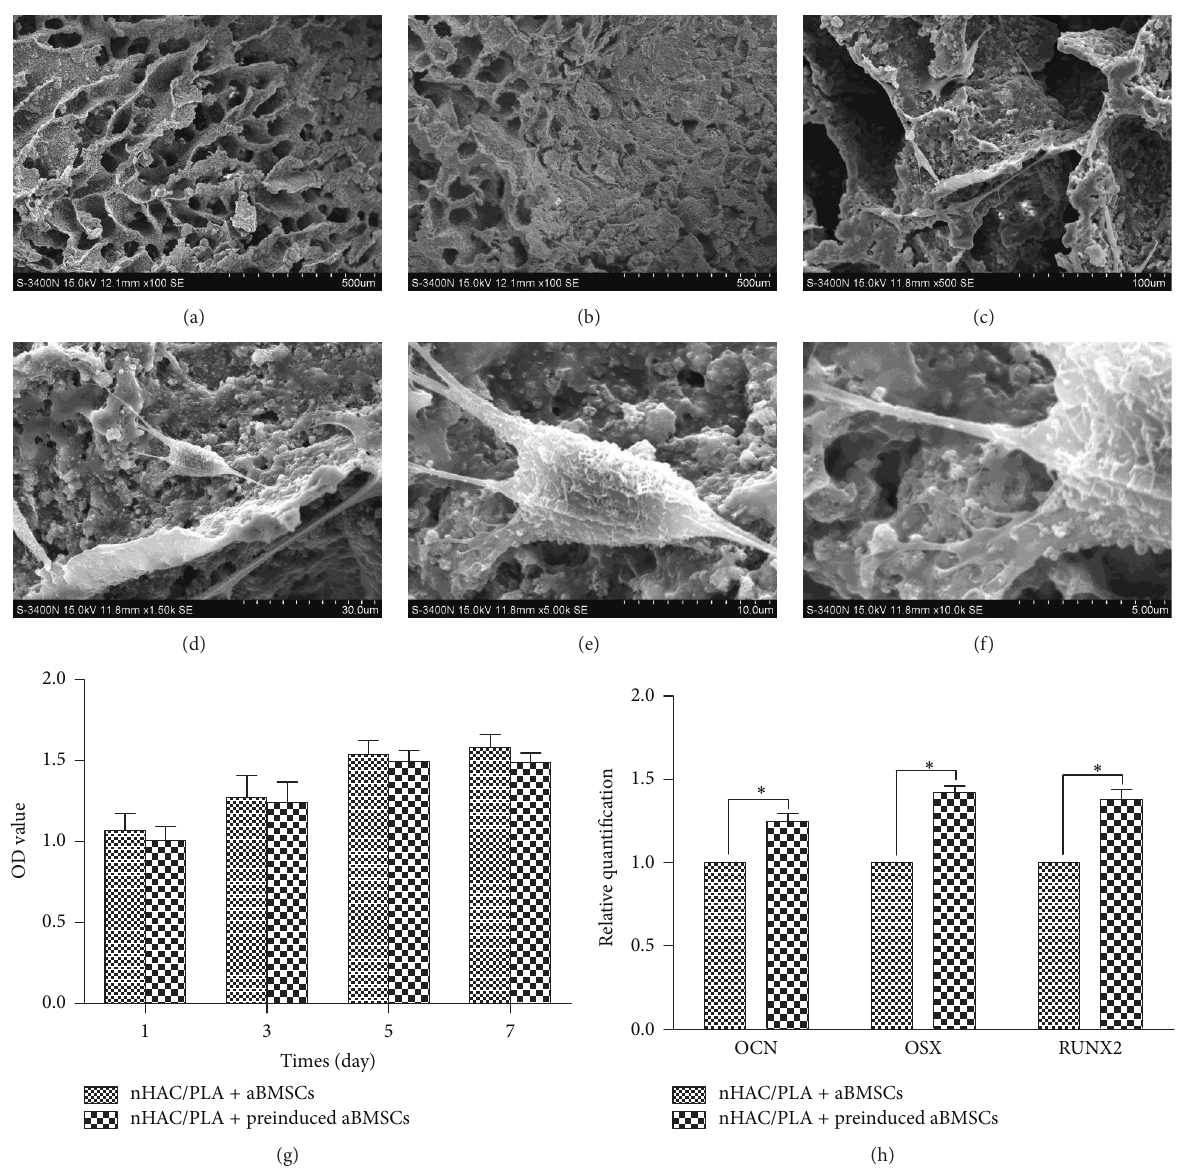
Figure 3: Proliferation and osteogenic differentiation potential of aBMSCs on nHAC/PLA. (a) SEM analysis showed that nHAC/PLA was similar to natural bone in terms of microstructure. (b) After 3 days of culture, the aBMSCs adhered to, extended, and connected with each other and produced ECM on the nHAC/PLA surface. The aBMSCs (c–f) were spindle, triangle, or cube shaped, with developed cytoplasmic extensions attached to the scaffold. (g) The MTS results demonstrated that the aBMSCs were proliferative on days 1, 3, 5, and 7 after seeding onto nHAC/PLA ( 𝑛 = 6 , mean ± SD). (h) Real-time PCR revealed that osteogenic induction for 7 days promoted aBMSC expression of OCN, Runx2, and Osterix ( 𝑛 = 6 , mean ± SD). ∗ Compared with nHAC/PLA + aBMSCs. Differences are significant at 𝑝 < 0.05 . Magnification: (a, b) × 100 SE; (c) × 500 SE; (d) × 1.50k SE; (e) × 5.00 k SE; (f) × 10.0k